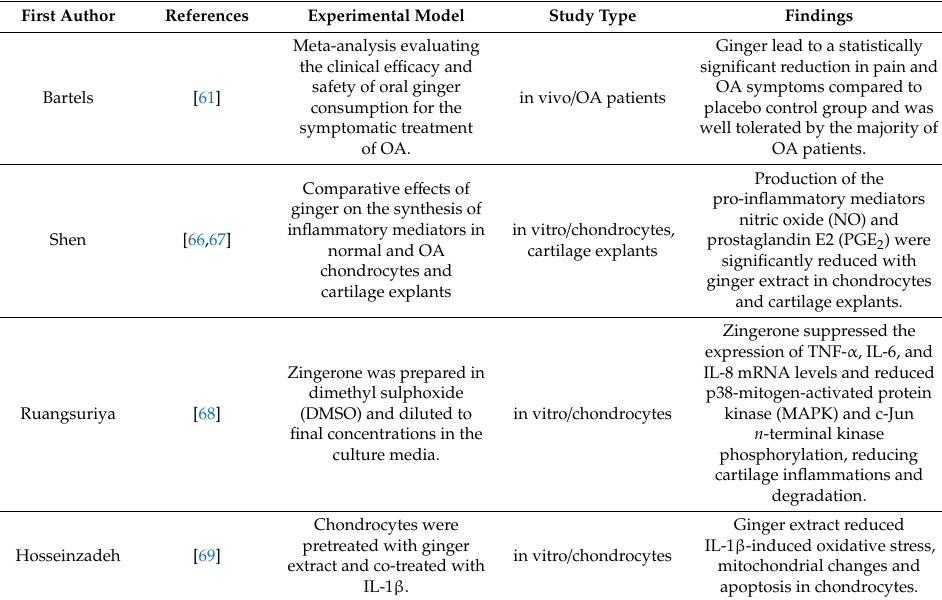
Table 2. Ginger application in cartilage tissue